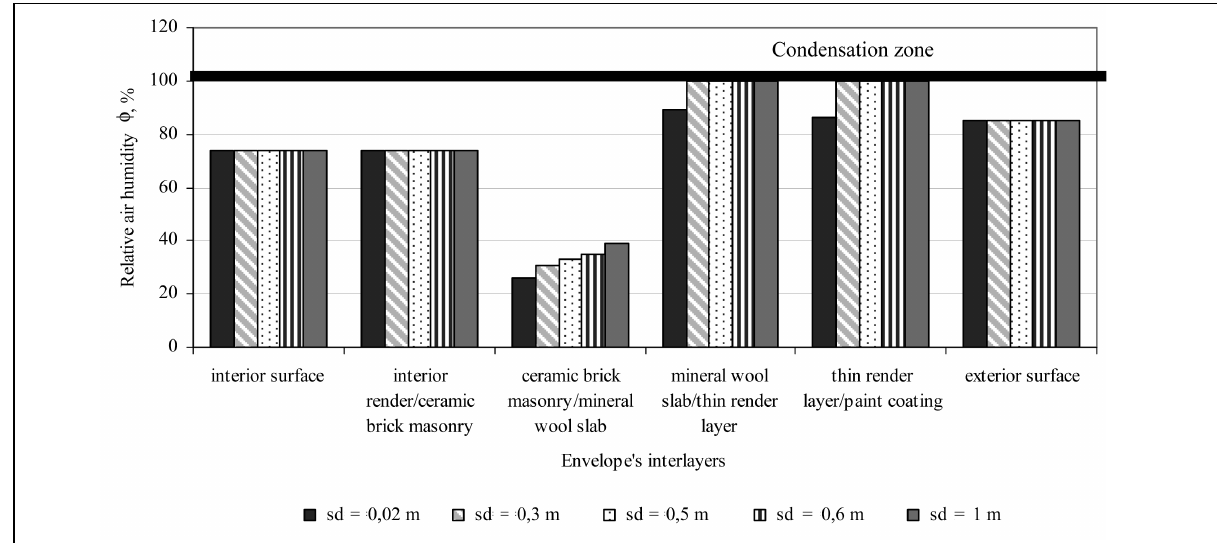
Fig 7. Dependence of the paint coating with various moisture characteristics on the moisture state of the insulated wall